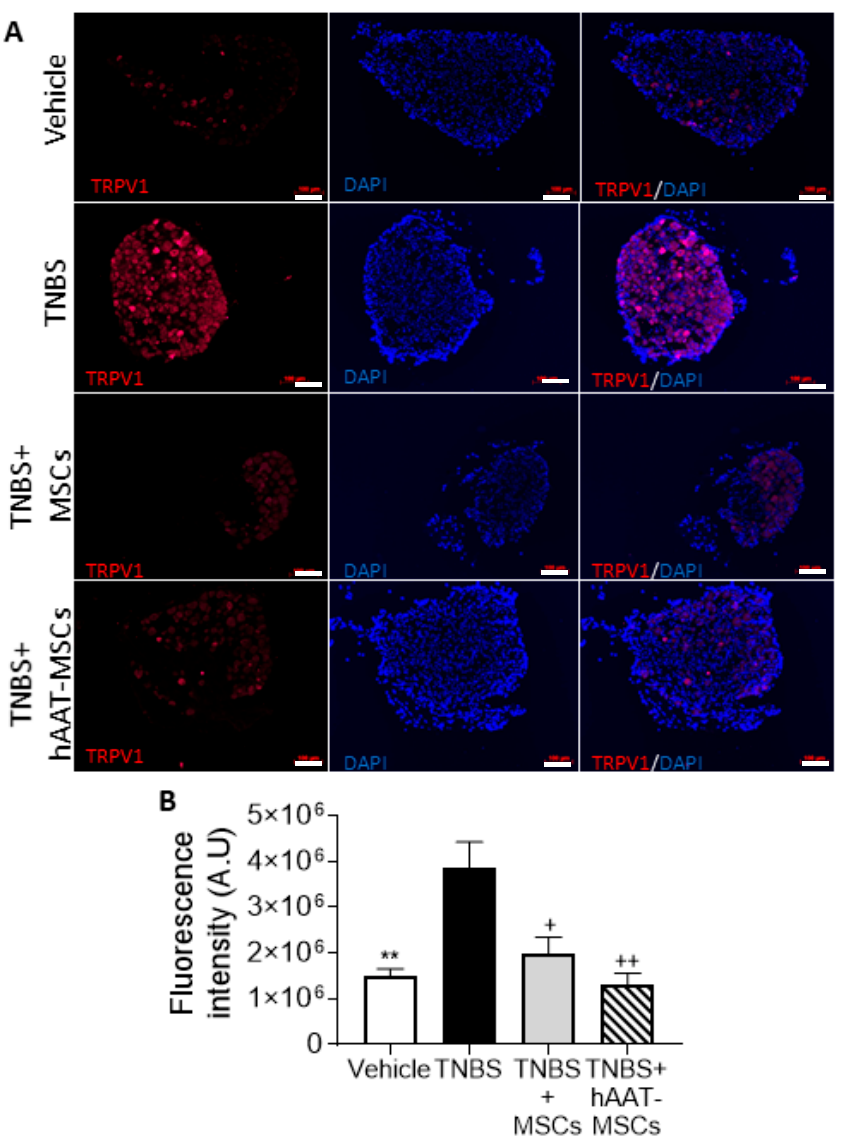
Figure 4. Human alpha-1 antitrypsin-overexpressed mesenchymal stromal cells (hAAT-MSC) and MSC infusions reduced transient receptor potential cation channel subfamily V member 1 (TRPV1) expression. Dorsal root ganglions (DRG) from T9-12 were harvested at 4 weeks after trinitrobenzene sulfonic acid (TNBS) injection and ( A ) the expression of TRPV1, a pain receptor that is associated with chronic pain, was examined (Vehicle = 5, TNBS = 5, TNBS + MSCs = 3, TNBS + hAAT-MSCs = 3 mice per group). Scale bar = 100 μ m ( B ) TRPV1 expression in DRGs increased significantly in TNBS-treated mice, and hAAT-MSC or MSC treatment drastically reduced its expression, suggesting that MSCs might reduce pain via downregulation of TRPV1 expression. Data presented are mean ± SEM. One-way ANOVA and Tukey’s test were used. ** p < 0.01 vs. Vehicle, + p < 0.05, ++ p < 0.01 vs. TNBS.